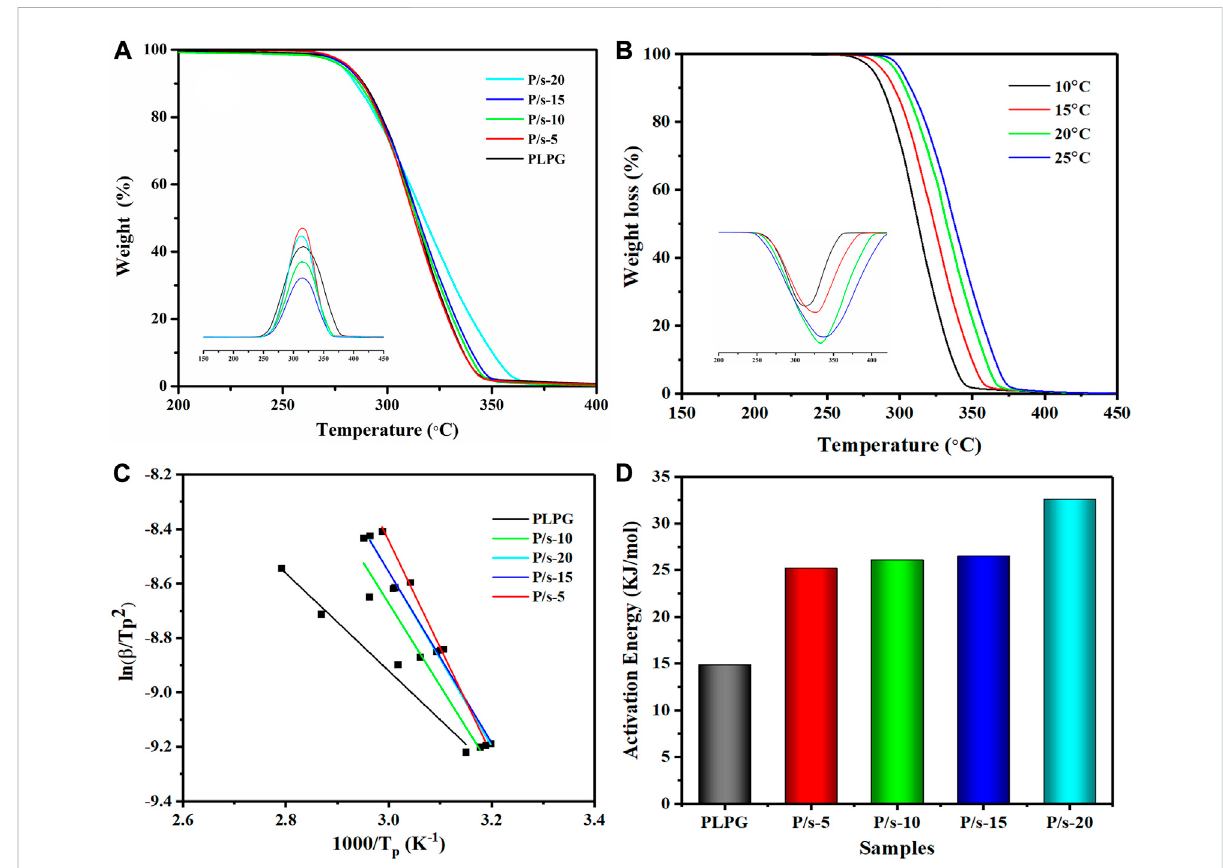
FIGURE 3 (A) TGA and DTG of the P/s membrane at 10 ° C/min, (B) TGA and DTG of the P/s-20 at 10, 15, 20, and 25 ° C/min, (C) Kissinger method that was applied to the experimental data, and (D) apparent E a